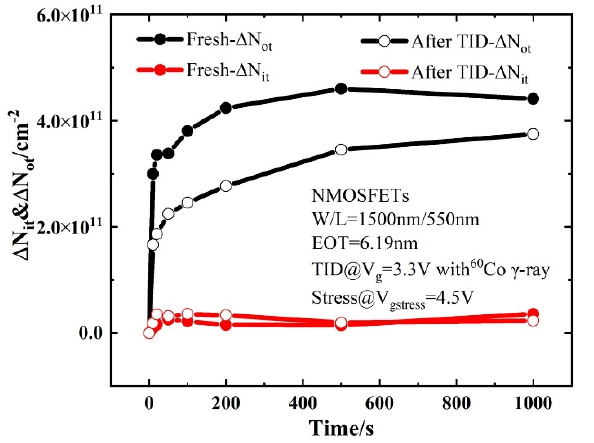
Figure 9. The relationship between Δ N it and Δ N ot and electrical stress time for the fresh devices and devices after TID.